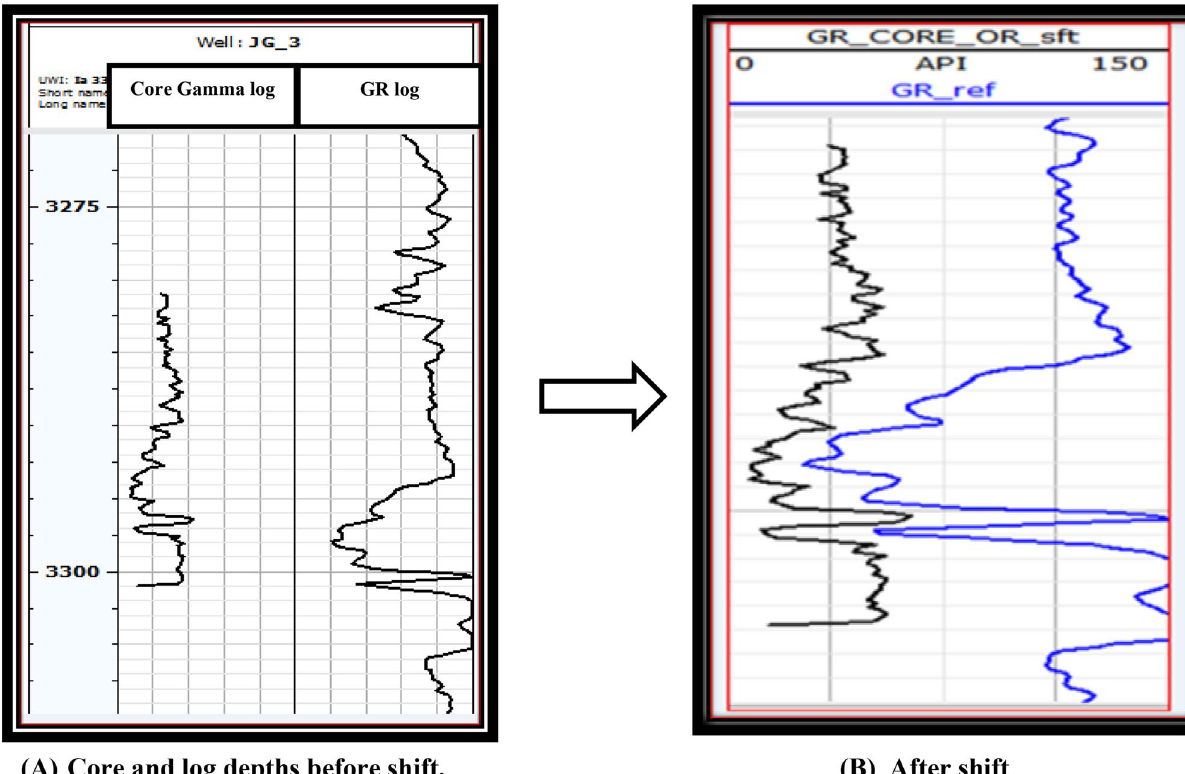
Fig. 9 a Core and log depths before shift. b after